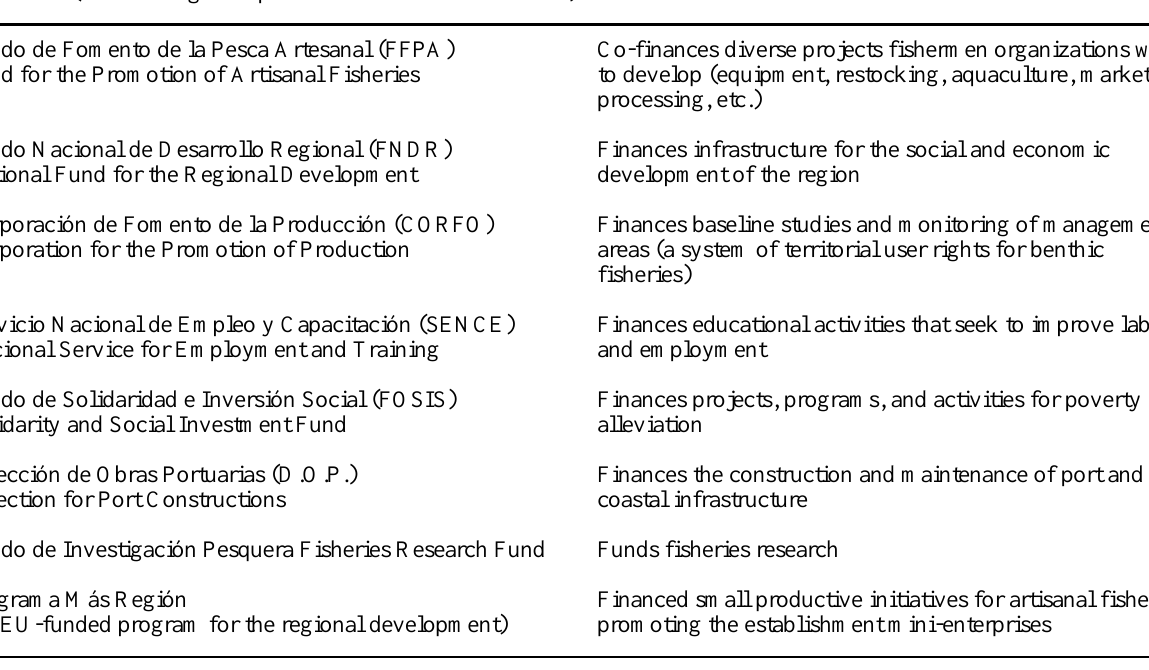
Table 1 . Institutions that funded development programs or actions and research during the period 1996– 2007 in the Coquimbo Region,